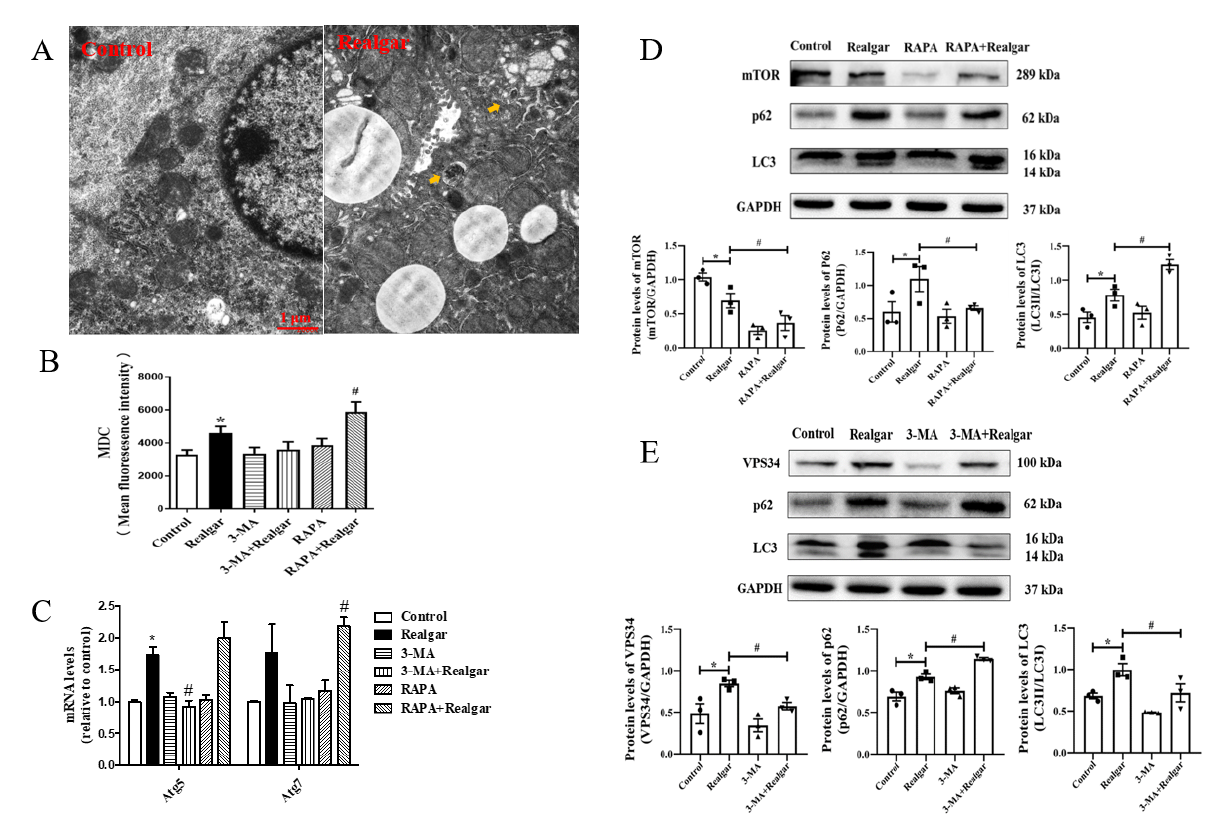
Figure 1. Regulation of autophagy in mouse livers. ( A ) Electron microphotographs showed the changes of hepatocytes. scale bar:1 µ m; magnified 20,000 × . The arrows refer to the autophagic vacuoles. ( B ) The fluorescence intensity of MDC-labeled autophagic vacuoles ( n = 6). ( C ) The relative mRNA levels of Atg5 and Atg7 were evaluated by RT-qPCR and normalized the data to Gapdh ( n = 3). ( D ) Representative Western blots and quantitative analysis of the protein expressions of mTOR, P62 and LC3II/I in RAPA treated groups. The gray value of the bands was normalized to GAPDH ( n = 3). ( E ) Representative Western blots and quantitative analysis of the protein expressions of VPS34, P62 and LC3II/I in 3-MA treated groups. The gray value of the bands was normalized to GAPDH ( n = 3). Data are presented as mean ± SEM. * p < 0.05, compared with control group; # p < 0.05, compared with realgar-treated group.